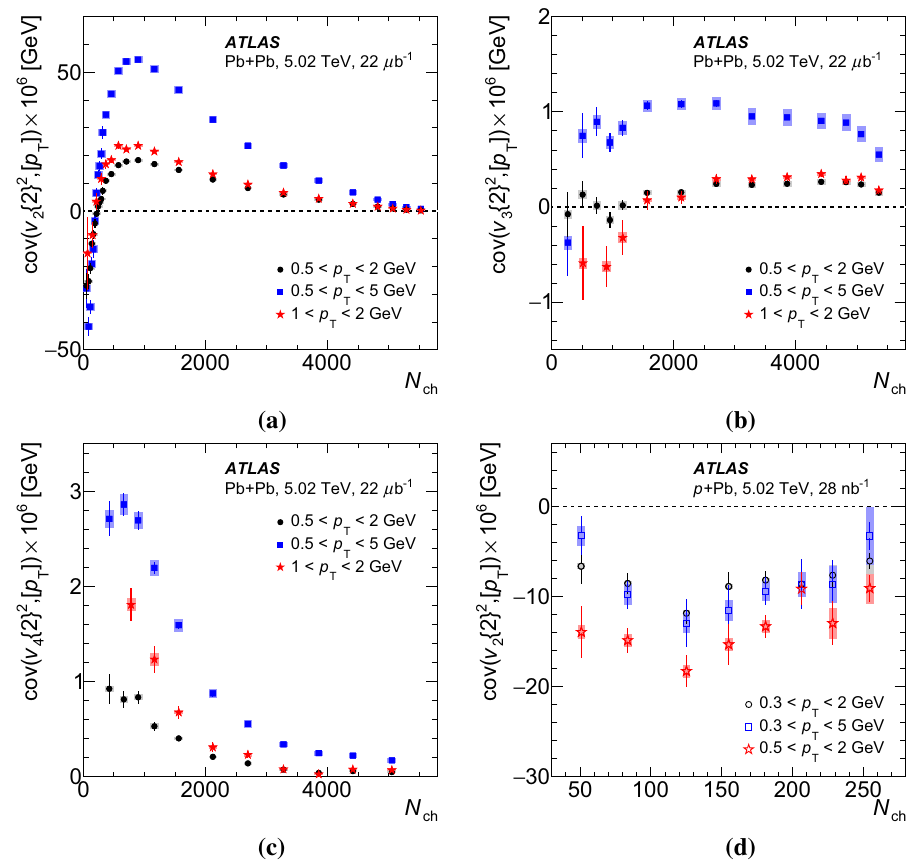
Fig. 4 The covariance cov (v n { 2 } 2 , [ p T ] ) for n = 2 − 4 in a – c Pb+Pb collisions and cov (v 2 { 2 } 2 , [ p T ] ) in d p +Pb collisions for three p T ranges as a function of the charged-particle multiplicity N ch . The statistical and systematic uncertainties are shown as vertical error bars and boxes,